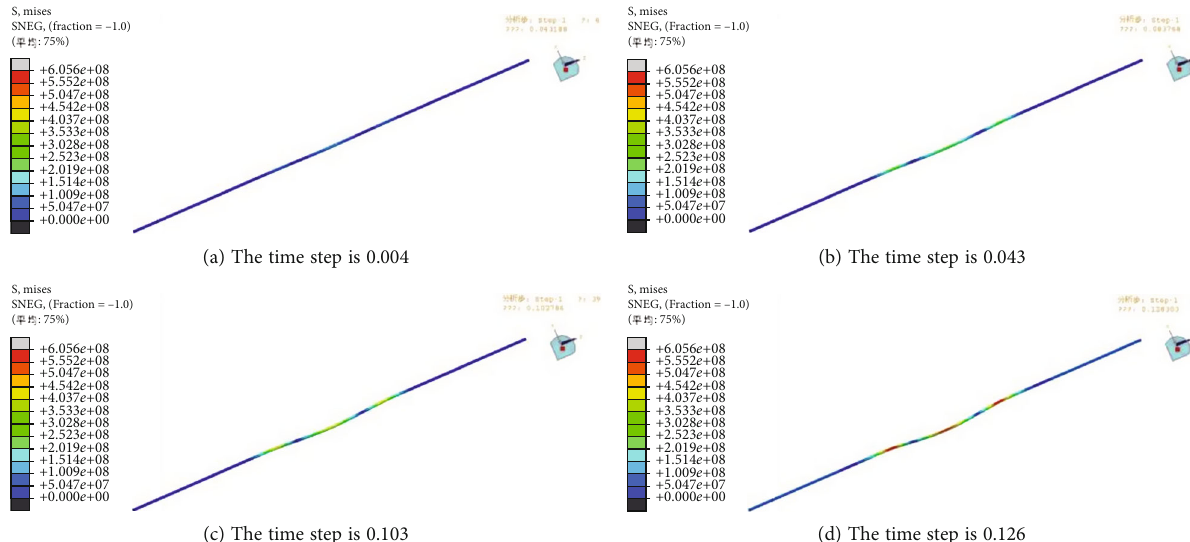
Figure 30: The pipeline stress at di ff erent time